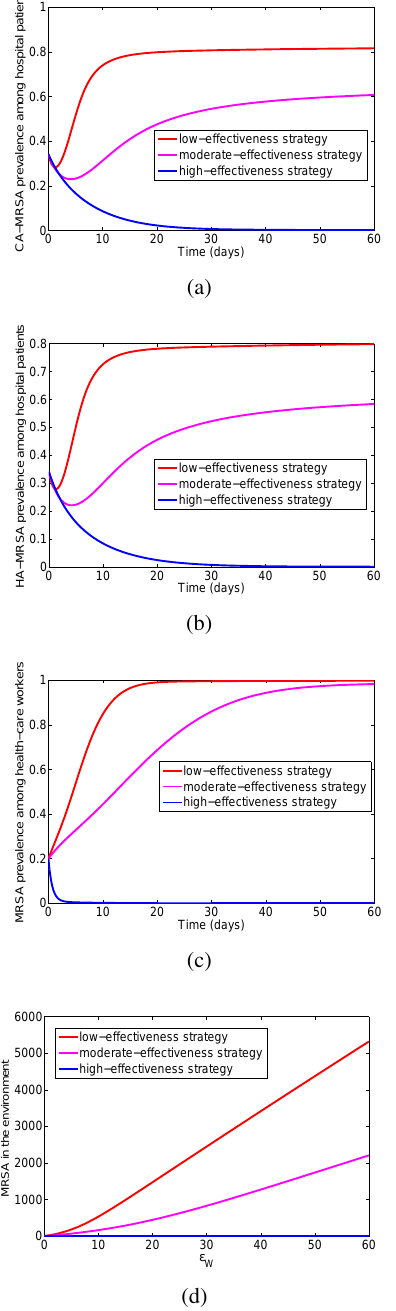
Fig. 4. Simulations of the model (2.1), showing the prevalence cases generated under various effectiveness levels of the control strategies. (a). CA-MRSA prevalence among hospital patients. (b). HA-MRSA prevalence among hospital patients. (c). MRSA prevalence among health-care workers. (d). MRSA in the environment. Other parameter values used are as given in Table II.